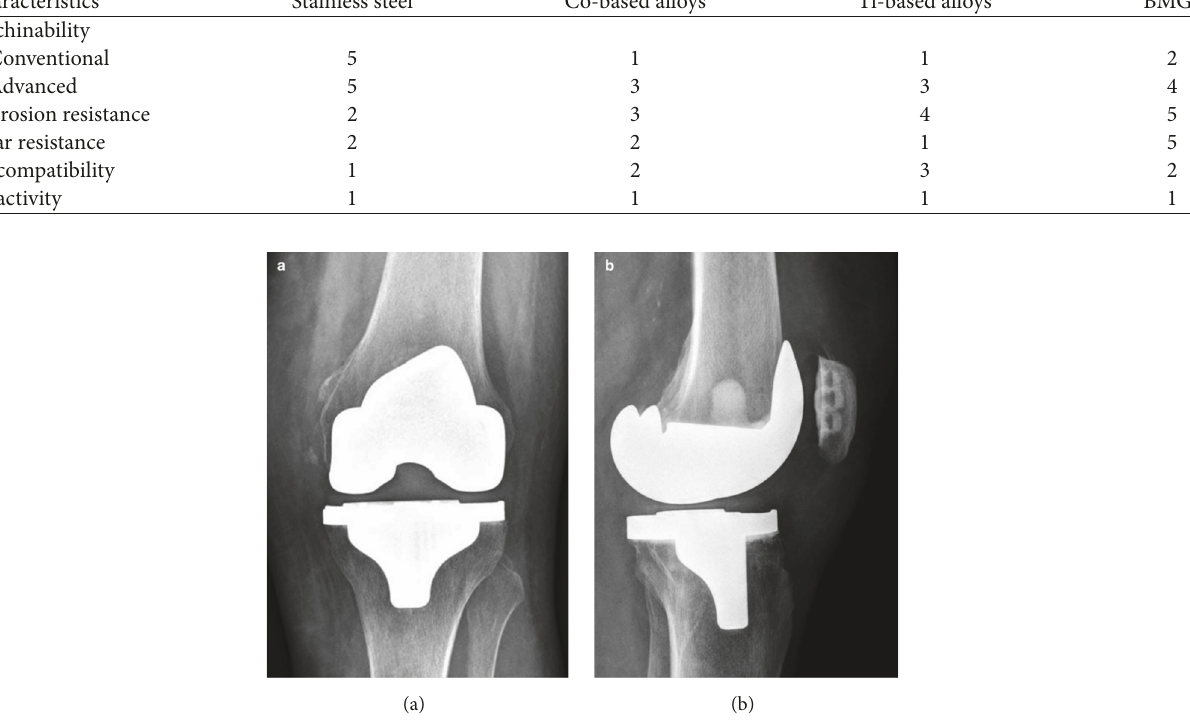
Figure 4: Anteroposterior (a) and lateral (b) radiographs demonstrating a total knee replacement [49].